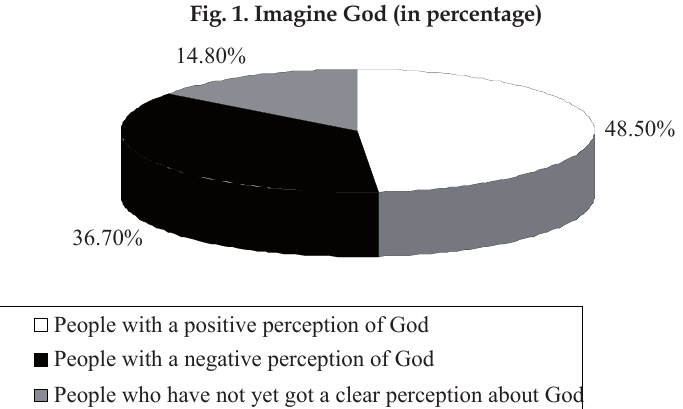
Fig. 1. Imagine God (in